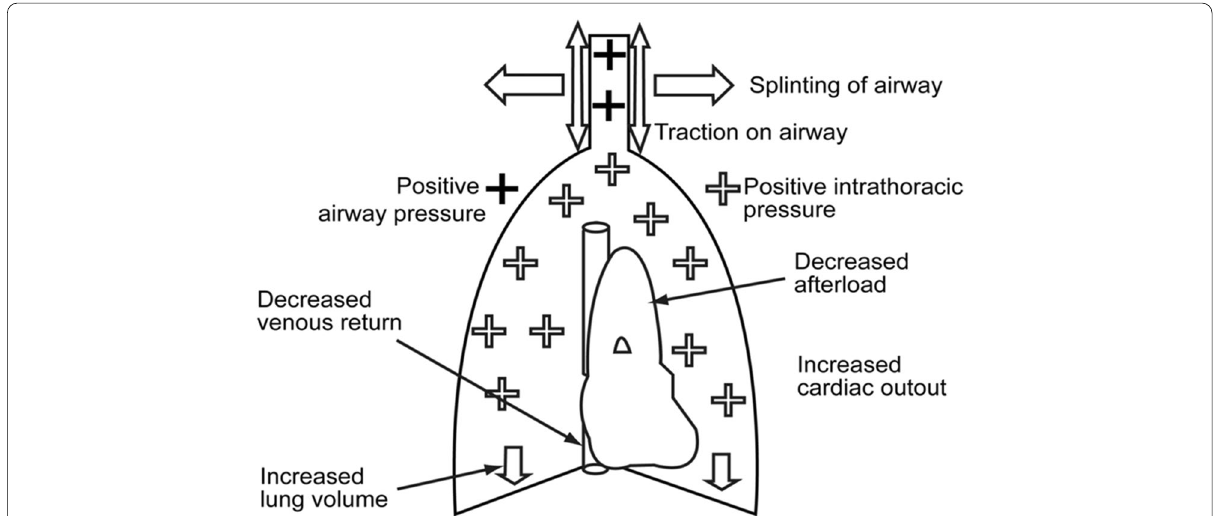
Fig. 1 Physiological effects of positive airway pressure (PAP)